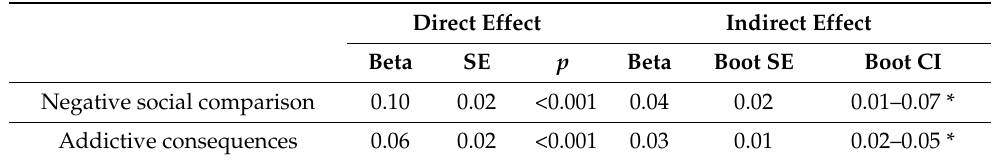
Table 3. Indirect effect analyses results, taking bullying victimization as the independent variable, the problematic use of social network subscales as mediators and loneliness as the dependent variable.